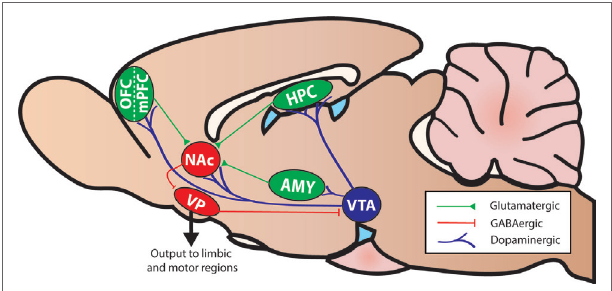
FiGURe 2 | A simplified diagram of the mesocorticolimbic system and associated structures in the rodent brain (sagittal view). Abbreviations: AMY, amygdala; HPC, hippocampus; NAc, nucleus accumbens; mPFC, medial prefrontal cortex; OFC, orbitofrontal cortex; VP, ventral pallidum; VTA, ventral tegmental